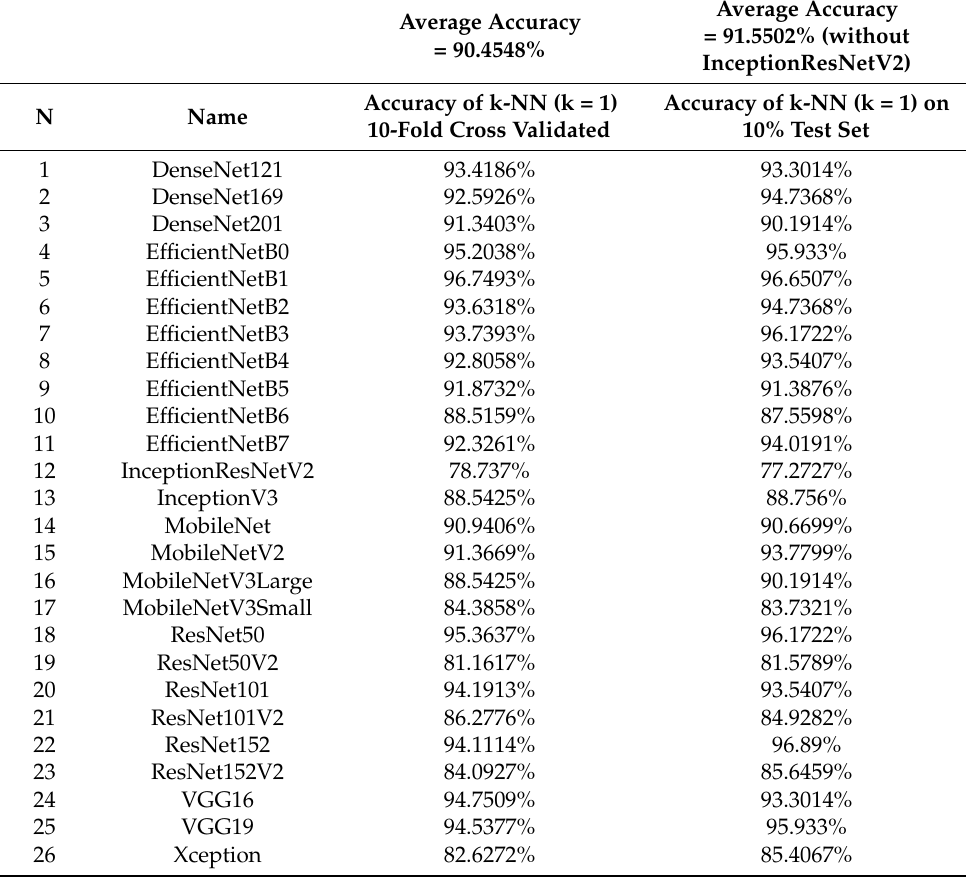
Table 3. Average accuracies of the 26